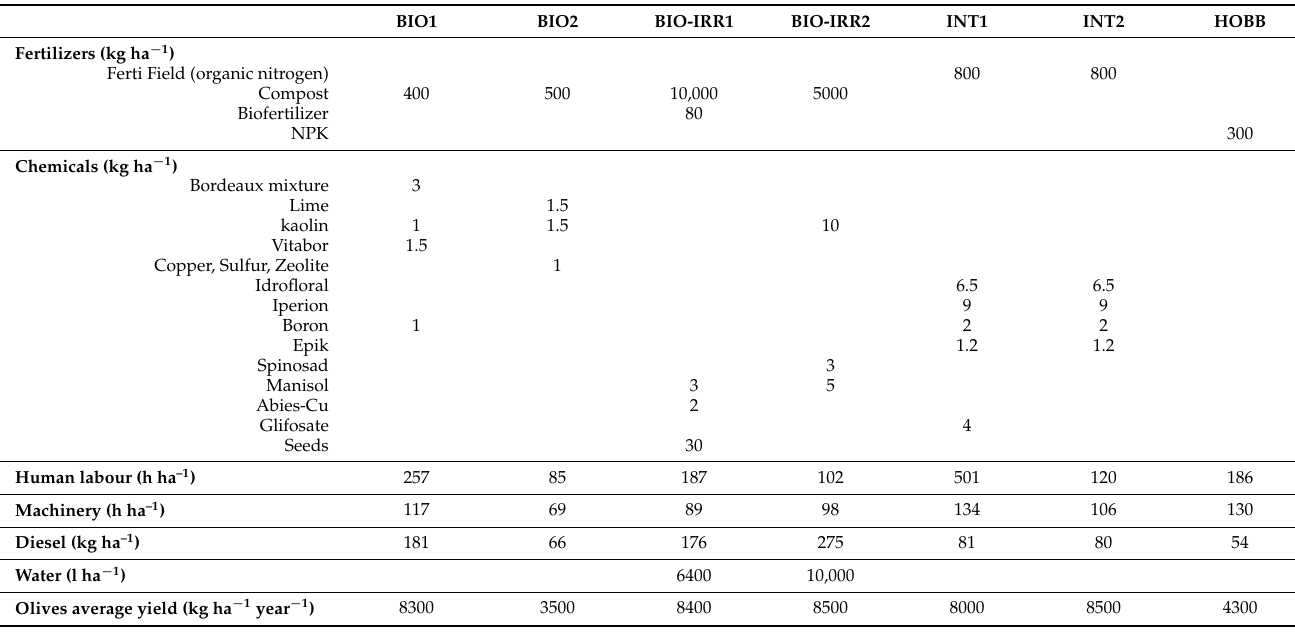
Table 2. Farm inputs and outputs used in the analyzed